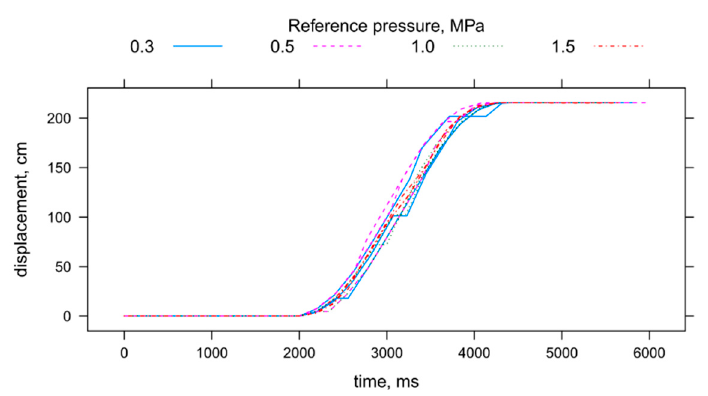
Figure 8. Position profiles of the mobile platform during the tests.